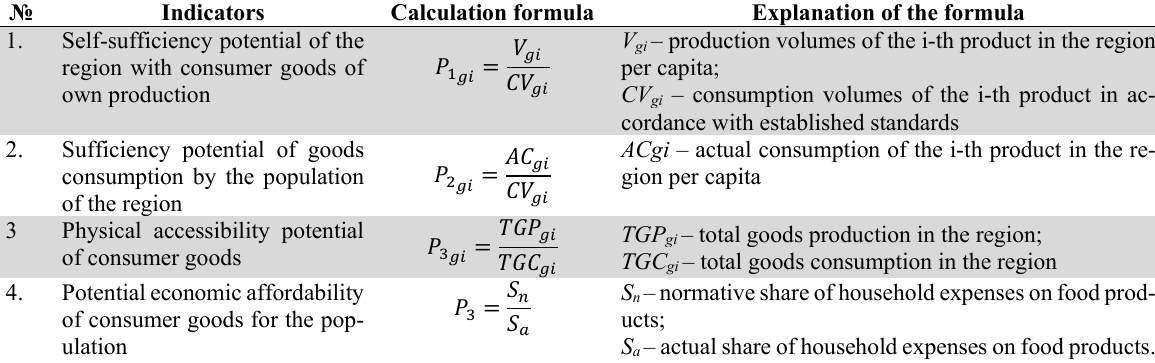
Indicators for assessing the regional food safety potential